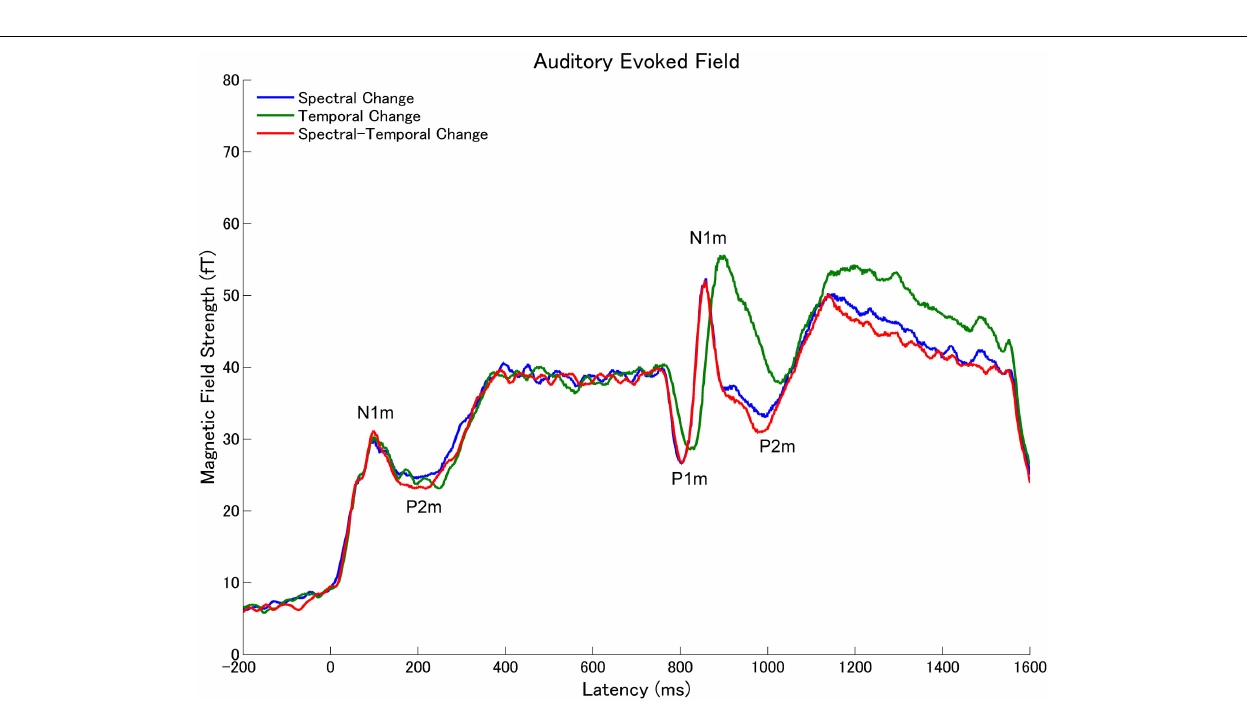
Frontiers in Psychology | Auditory Cognitive